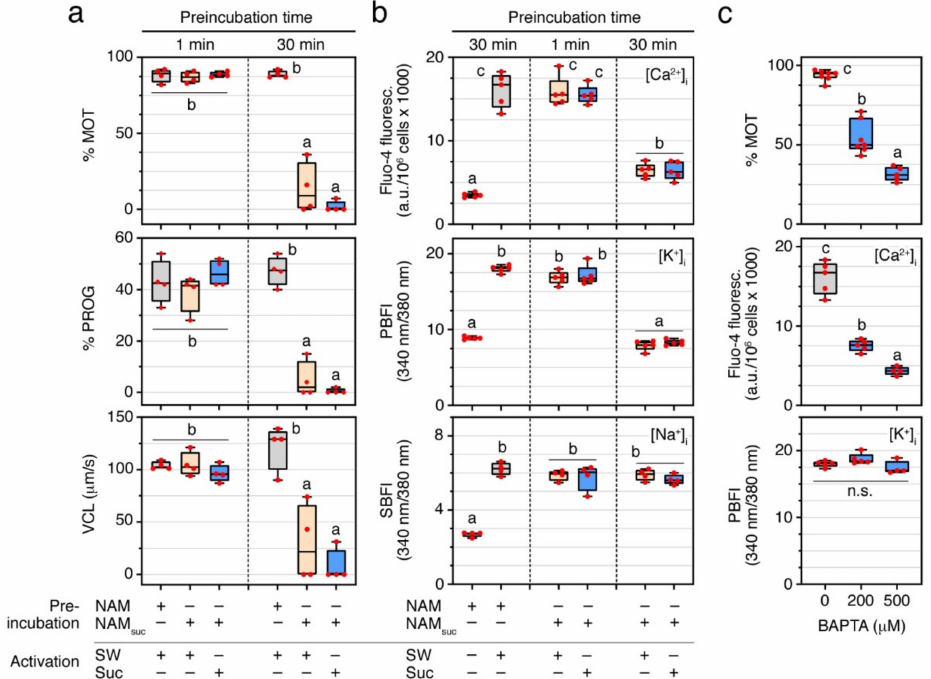
Figure 1. A surge of [Ca 2+ ] i , but not [K + ] i or [Na + ] i , independent of external ions, is necessary for the activation of sperm motility in the seabream. ( a ) Effect of different incubations times in standard non-activating medium (NAM) or NAM containing sucrose and no ions (NAM suc ), and further activation in seawater (SW) or sucrose (Suc) for 5 s, on spermatozoa motility (% MOT), progressivity (% PROG), and curvilinear velocity (VCL). ( b ) Levels of [Ca 2+ ] i , [K + ] i and [Na + ] at 5 s post activation in spermatozoa treated as in ( a ). ( c ) Percentage of MOT, and intracellular levels of Ca 2+ and K + , in sperm activated in SW containing increasing doses of BAPTA. In all panels, the data points are presented as box and whisker plots/scatter dots with horizontal line (inside box) indicating median and outliers. One ejaculate from each male was measured from n = 4–7 males. Data were statistically analyzed by one-way ANOVA. Boxes with different superscript are statistically significant ( p < 0.05). n.s., not